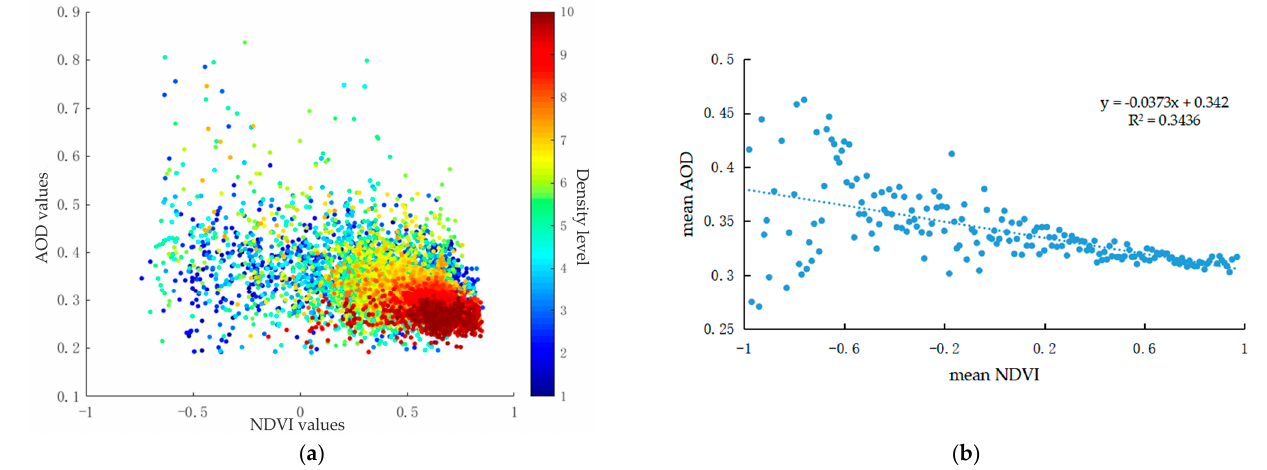
Figure 4. Relationship between AOD (Aerosol Optical Depth) and NDVI (Normalized Difference Vegetation Index) values: ( a ) scatterplots and ( b ) regression equation.